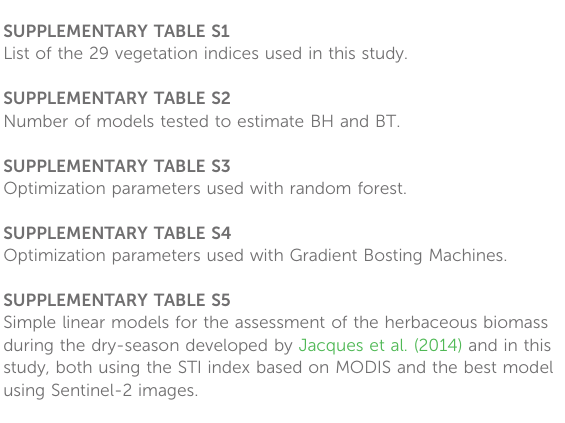
SUPPLEMENTARY TABLE S8 Performance of MLS, MML, RF and GBM models with